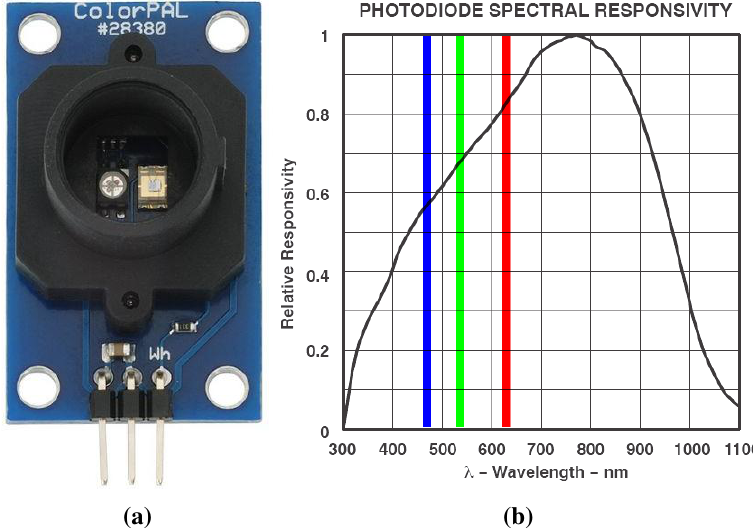
Figure 2. Picture of the ColorPAL module and its response. Picture of the ColorPal module ( a ) and its response ( b